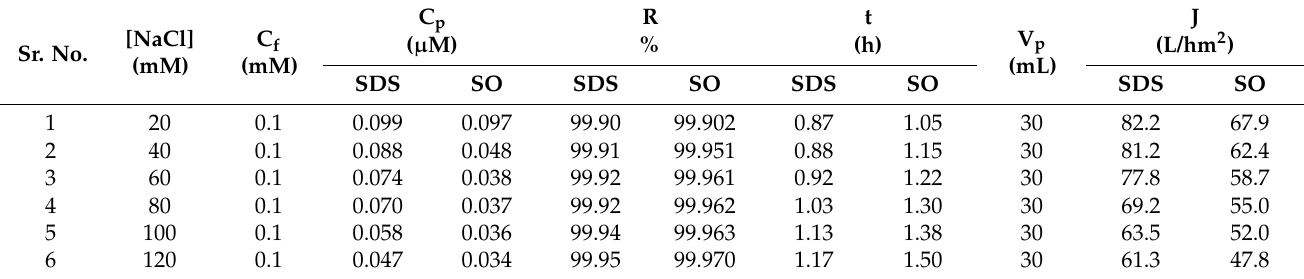
Table 3. Calculation of rejection coefficient (R%) and permeate flux (J) of Co 2+ using different electrolyte concentration (NaCl) in SDS and SO solutions, at fixed Co 2+ concentration in feed (C f